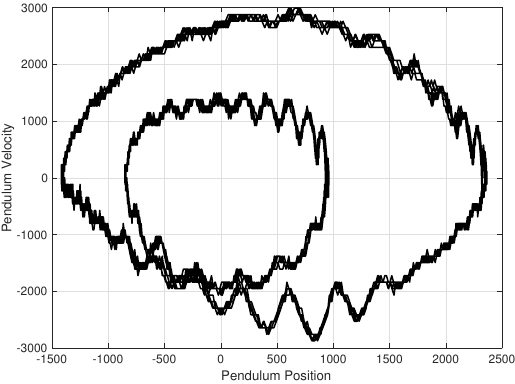
Figure 9. Pendulum position versus pendulum